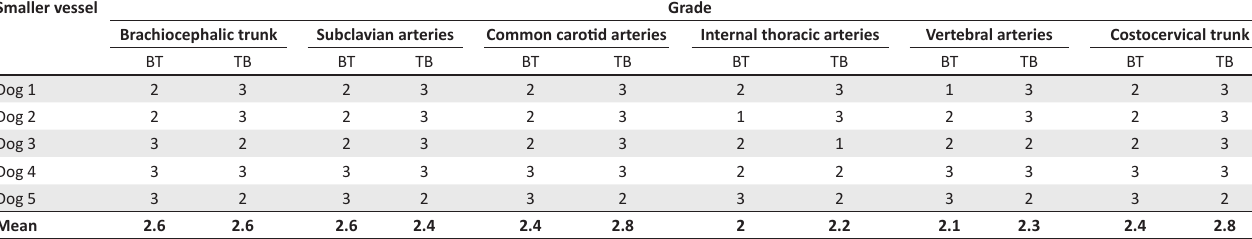
TABLE 2: Subjective assessment of the smaller cranial thoracic vessels during the arterial phase. Smaller vessel